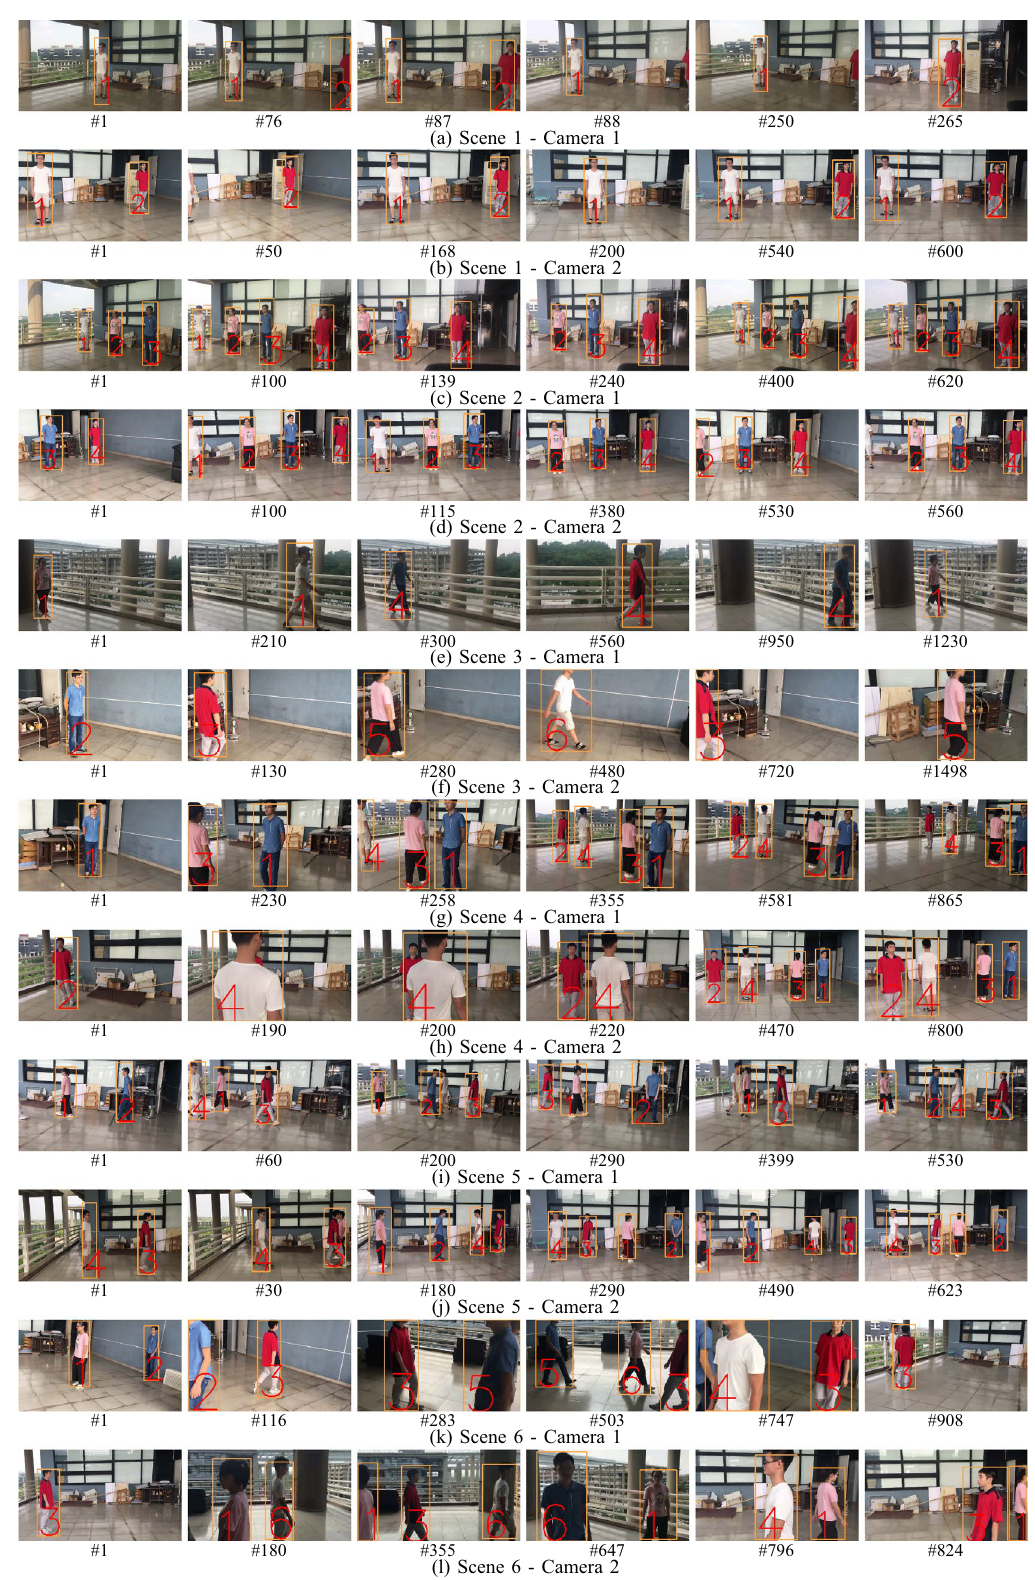
Figure 6. DMMA results on the proposed dataset. Different scenes show different frame numbers to better demonstrate the challenging